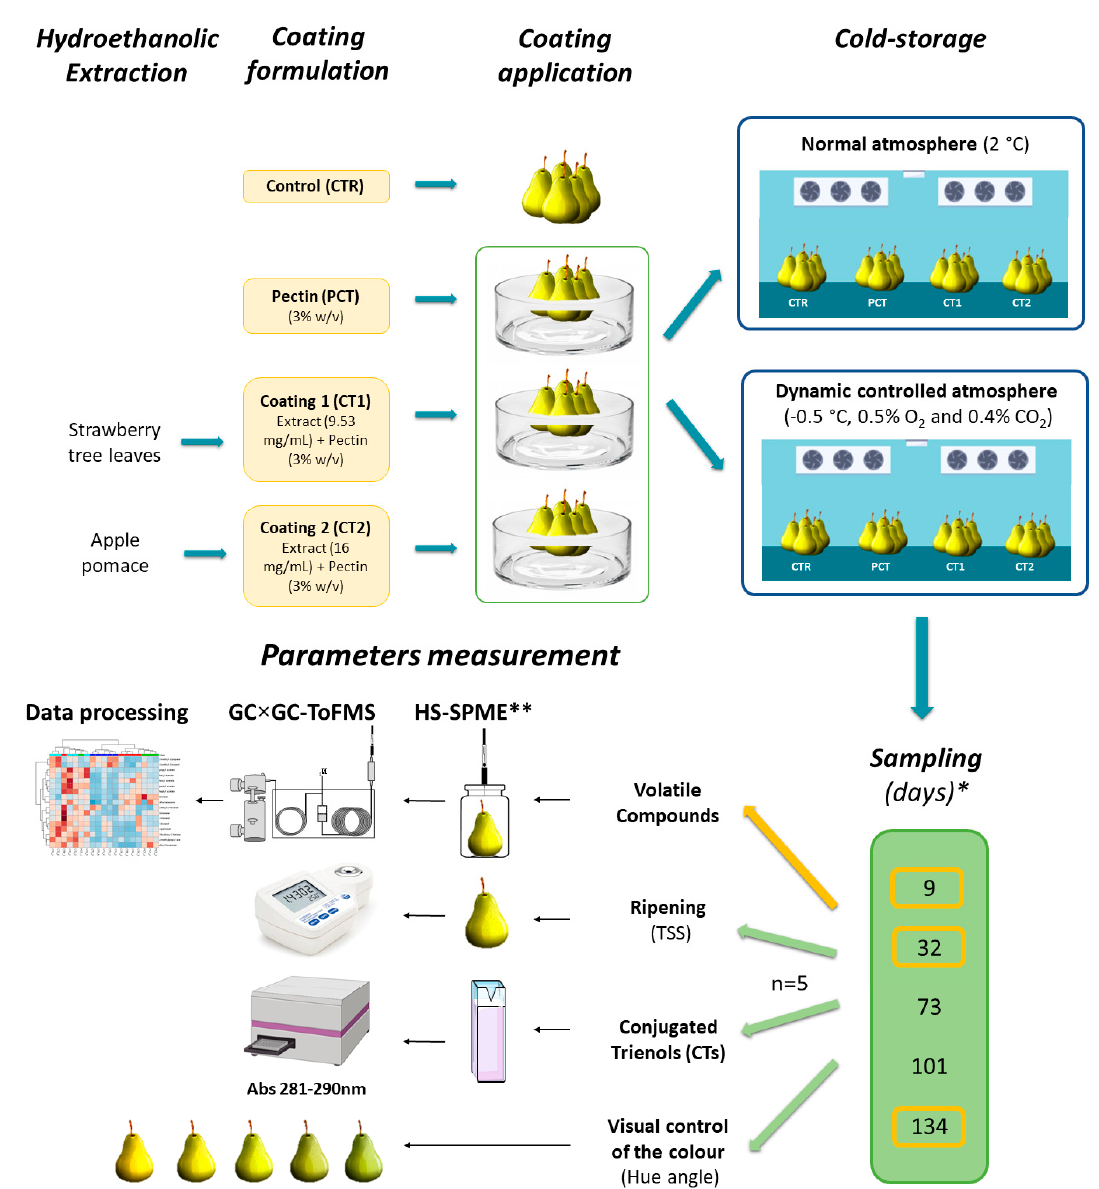
Figure 1. Schematic representation of the experimental design of the 4-month pilot-scale assay. Volatile compound analysis was performed for 9, 32, and 134 days, while conjugated trienols (CTs) determination, hue angle and total soluble solids (TSS) were performed for all available sampling times. * Days after coating application; ** after overnight